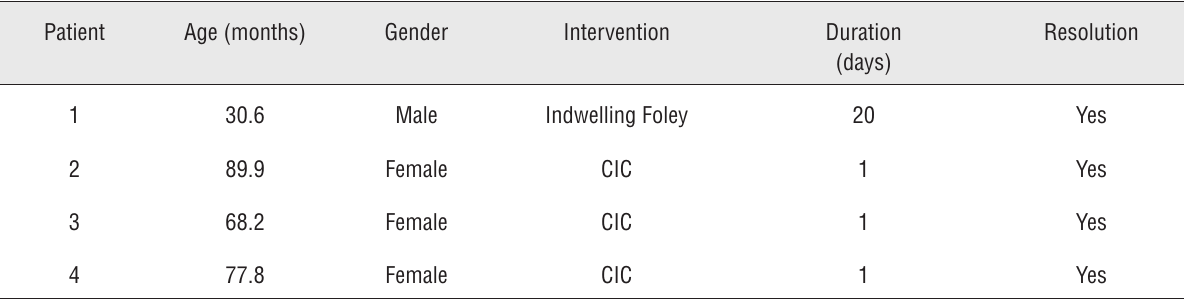
Table 4 - Characteristics of patients with postoperative urinary